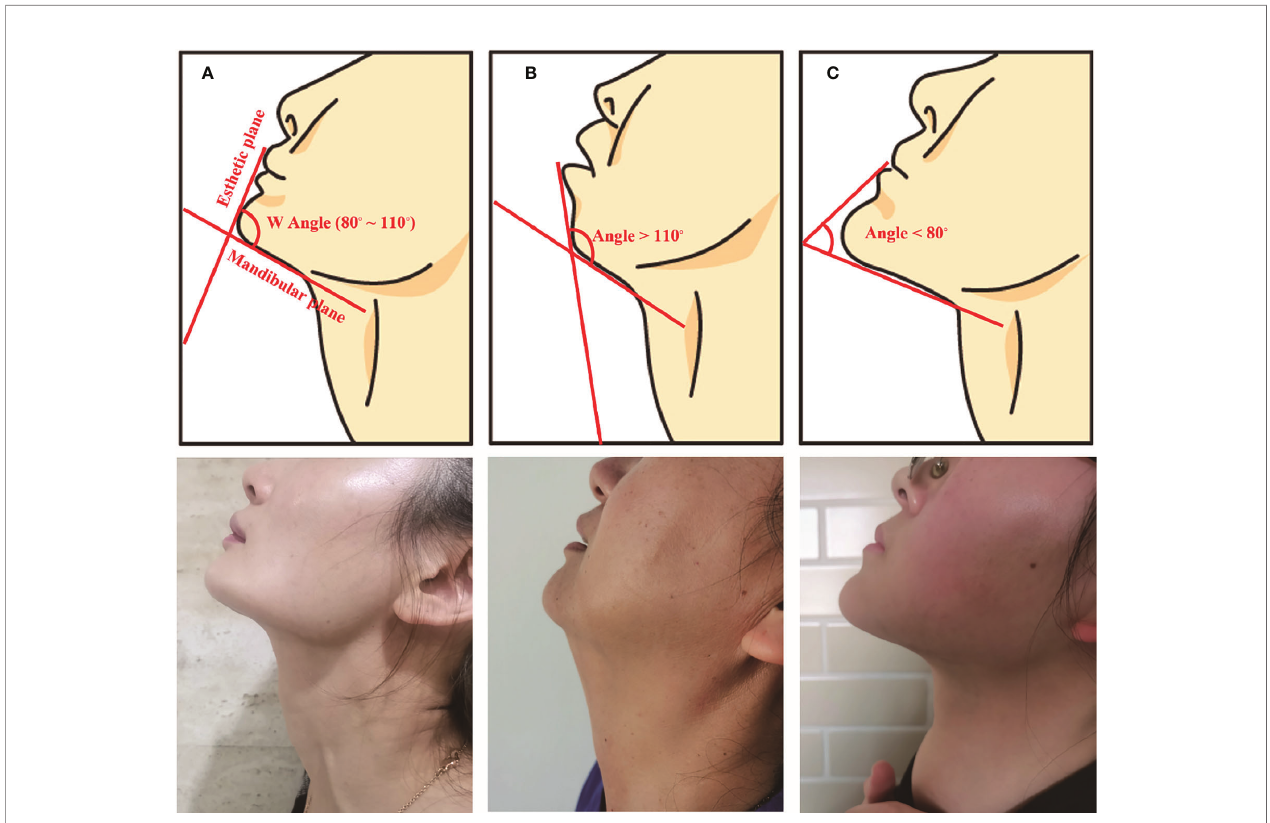
FIGURE 1 | Schematic diagram and realistic photos of the three classi fi cations: (A) (angle: 80° ~ 110°), (B) (angle > 110°), and (C) (angle < 80°)